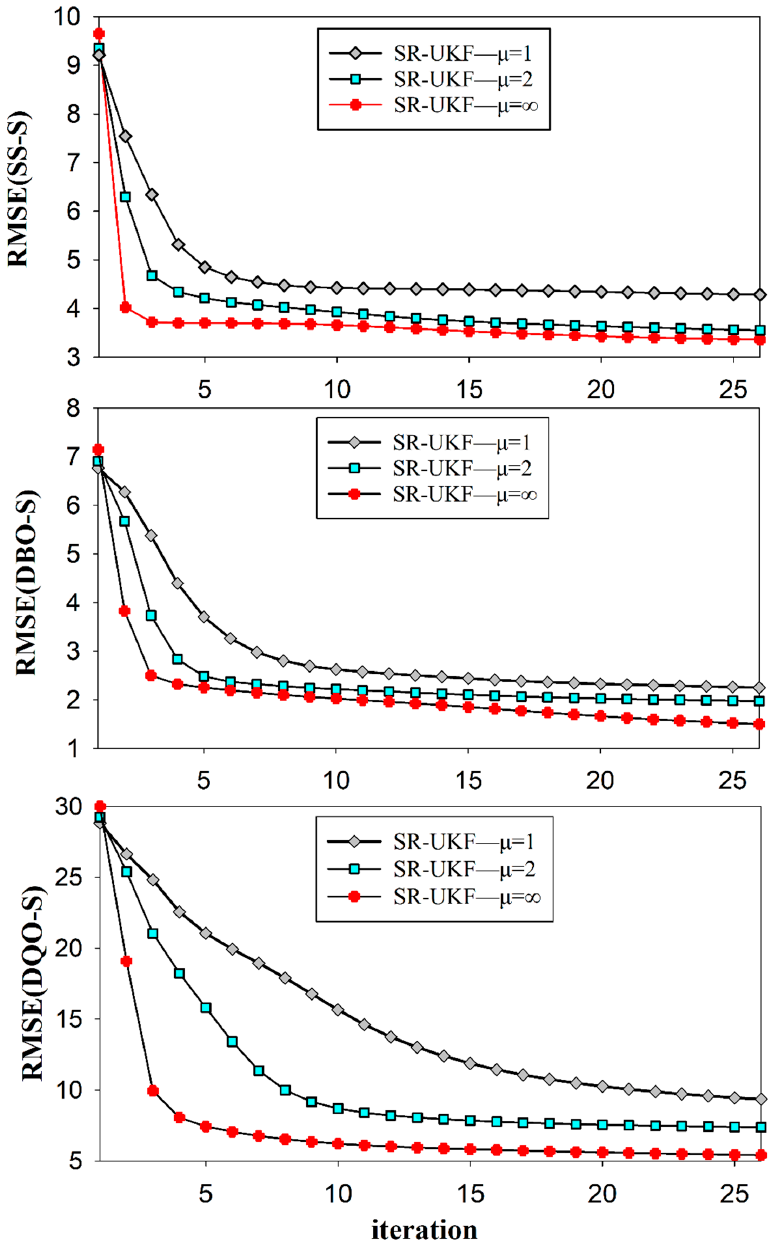
= 0.05𝑰 ). Figure 5. Convergence profiles of different weight constraints ( P x 0 = 0.05 I (cid:3116)